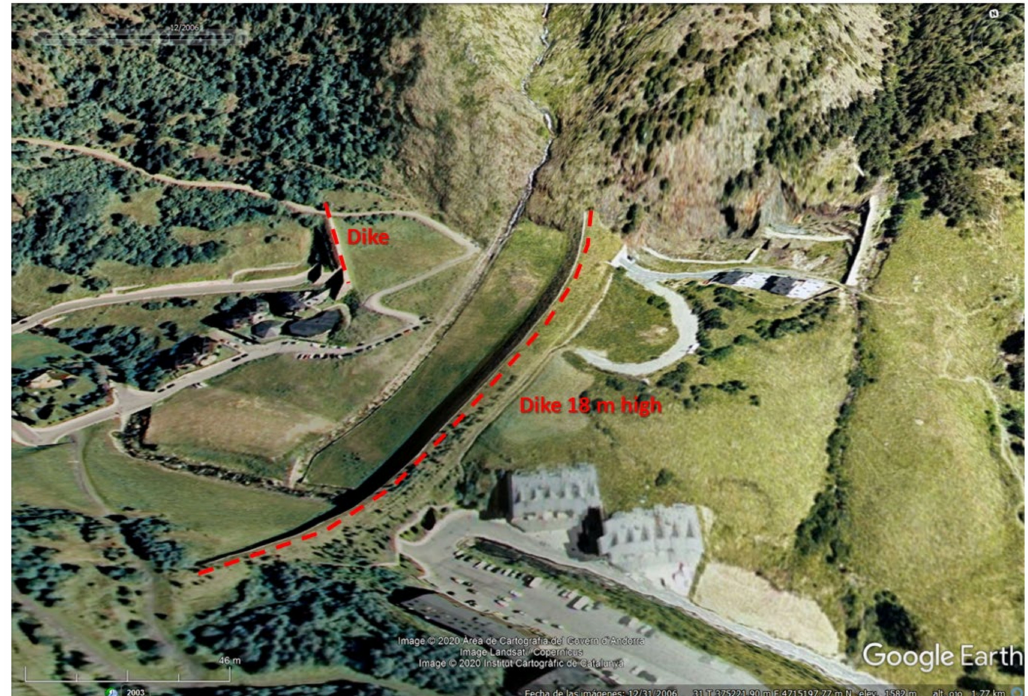
Figure 11. System of dikes in the run-out zone of Les Fonts d’Arinsal avalanche